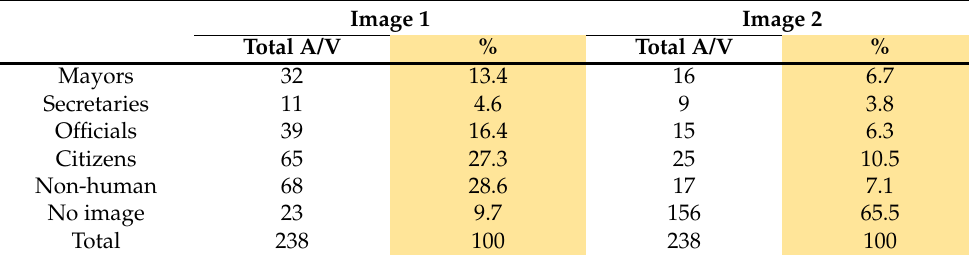
Table 8. Images 1 and 2 in the press (Source: